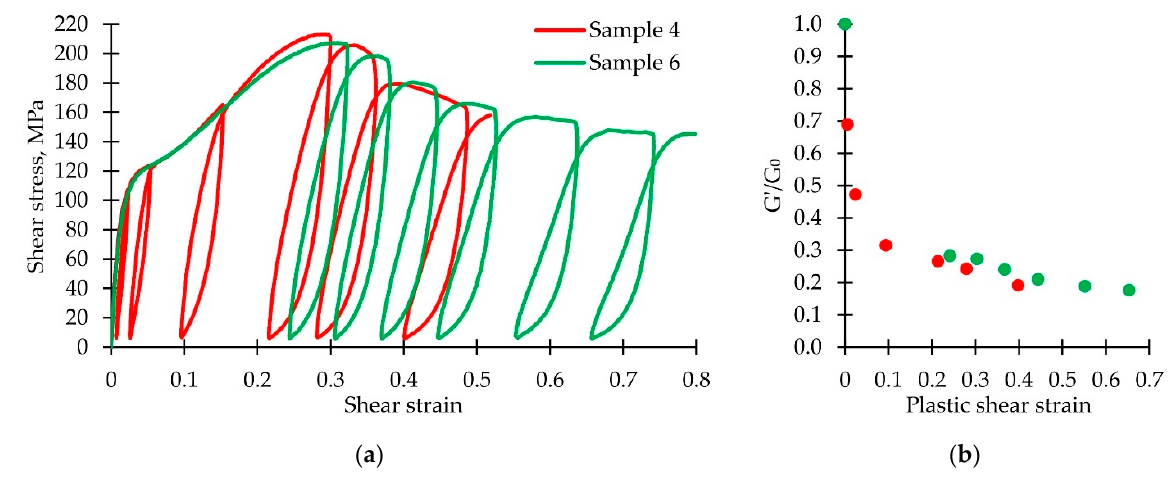
Figure 8. ( a ) Stress–strain curves; ( b ) shear modulus dependence on plastic strain. Table 2. Mechanical characteristics decrease and unloading-reloading loops